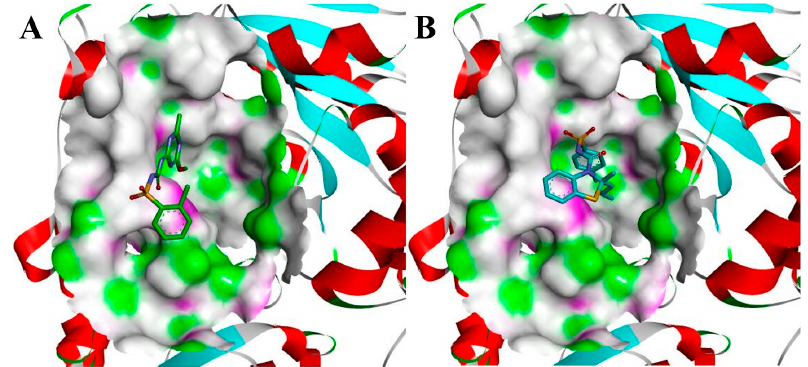
Figure 2. The docking modeling of chlorsulfuron ( A ) and 3c ( B ) with ALS. The carbon atoms are shown in green ( A ) and light blue ( B ), the sulfur atoms are shown in yellow, the oxygen atoms are shown in red, and the nitrogen atoms are shown in blue.